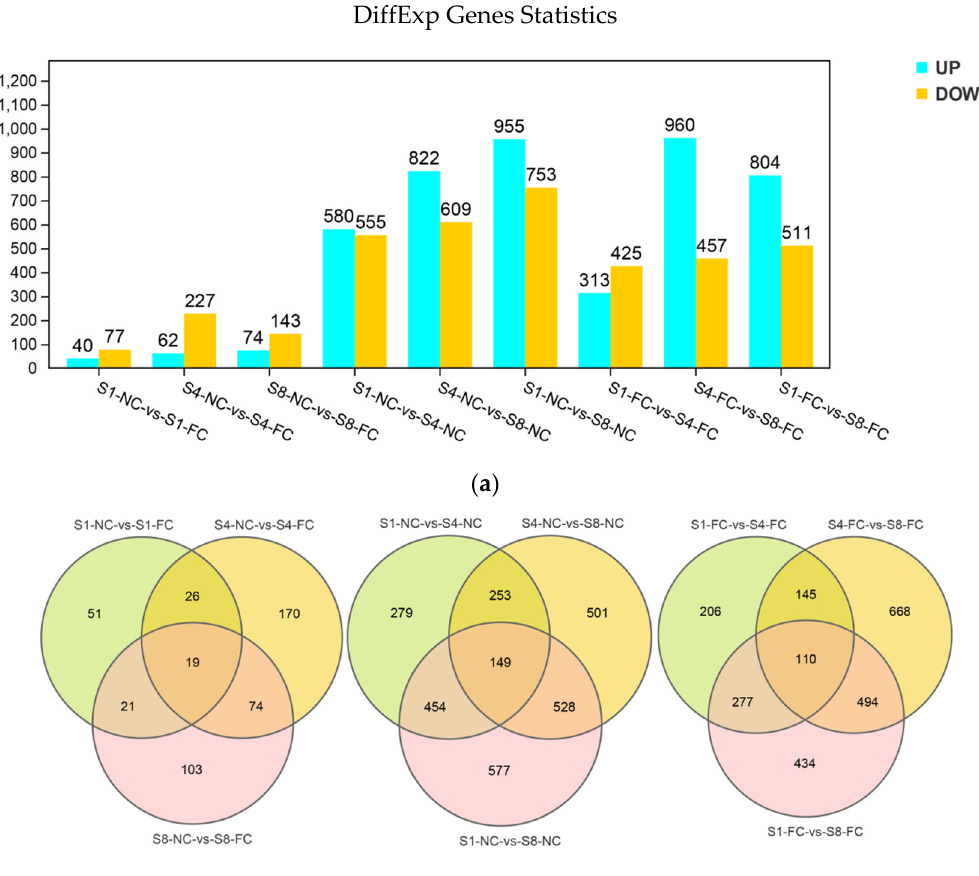
Figure 3. Statistical map of differential expression gene (DEGs). ( a ) Numbers of DEGs in pairwise comparisons. The X-axis indicates the name of each group; the Y-axis shows the gene number of genes within each group. NC indicates the fruit juice sacs near the core (NC), and FC indicates the fruit juice sacs far away from the core (FC) at three stages (S1, S4 and S8); ( b ) Venn diagram of shared DEGs between each group.